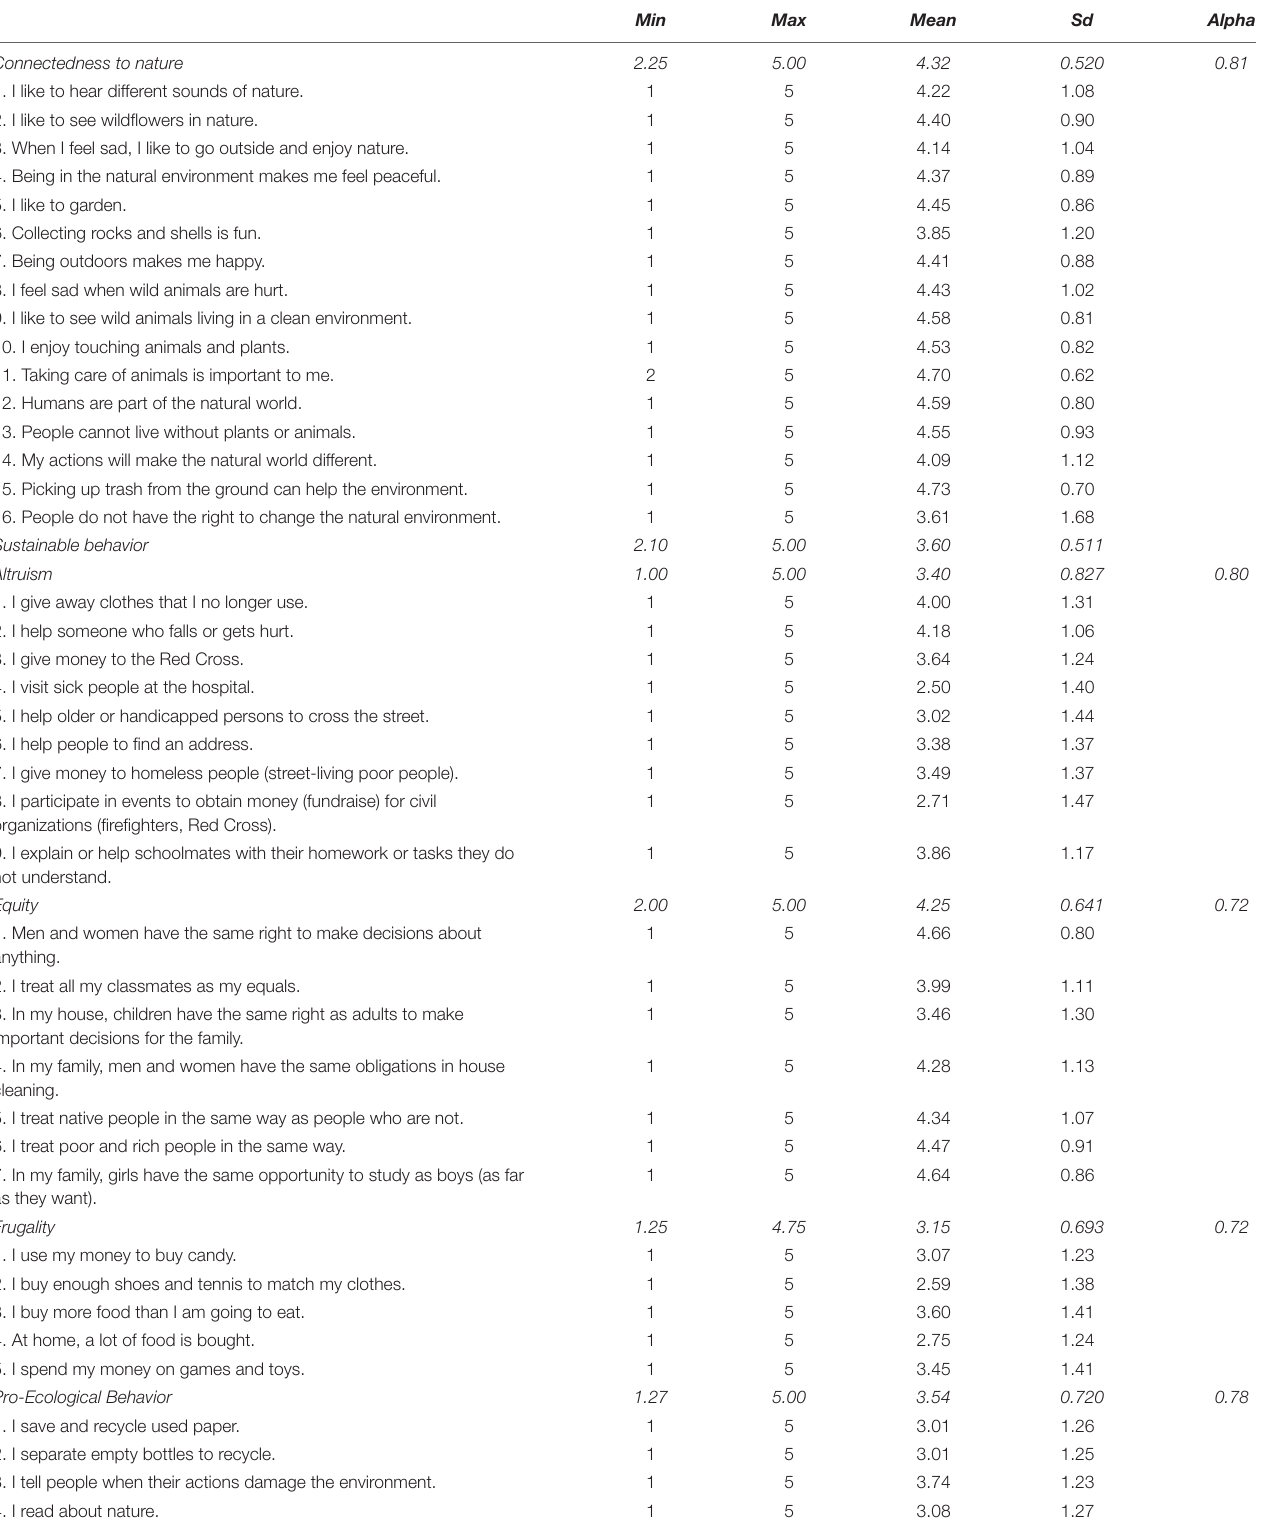
TABLE 1 | Univariate statistics and reliabilities of the used